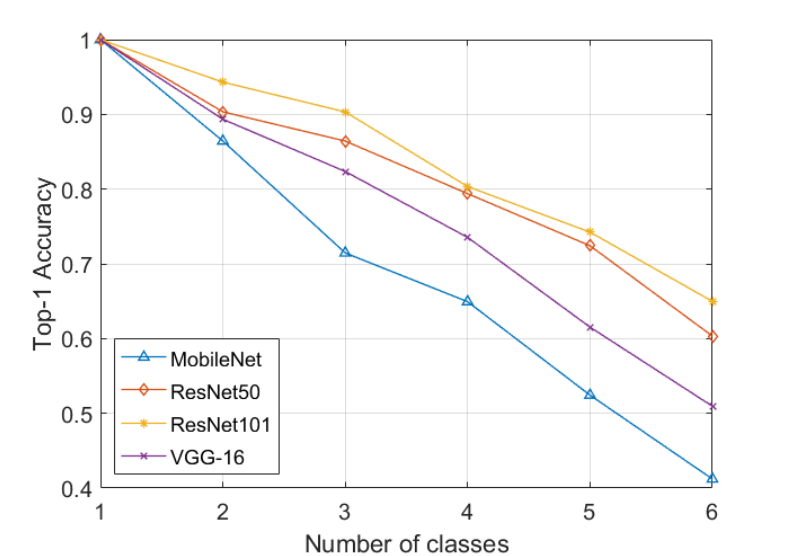
Figure 3. Incremental classification performance in terms of the top-1 accuracy on